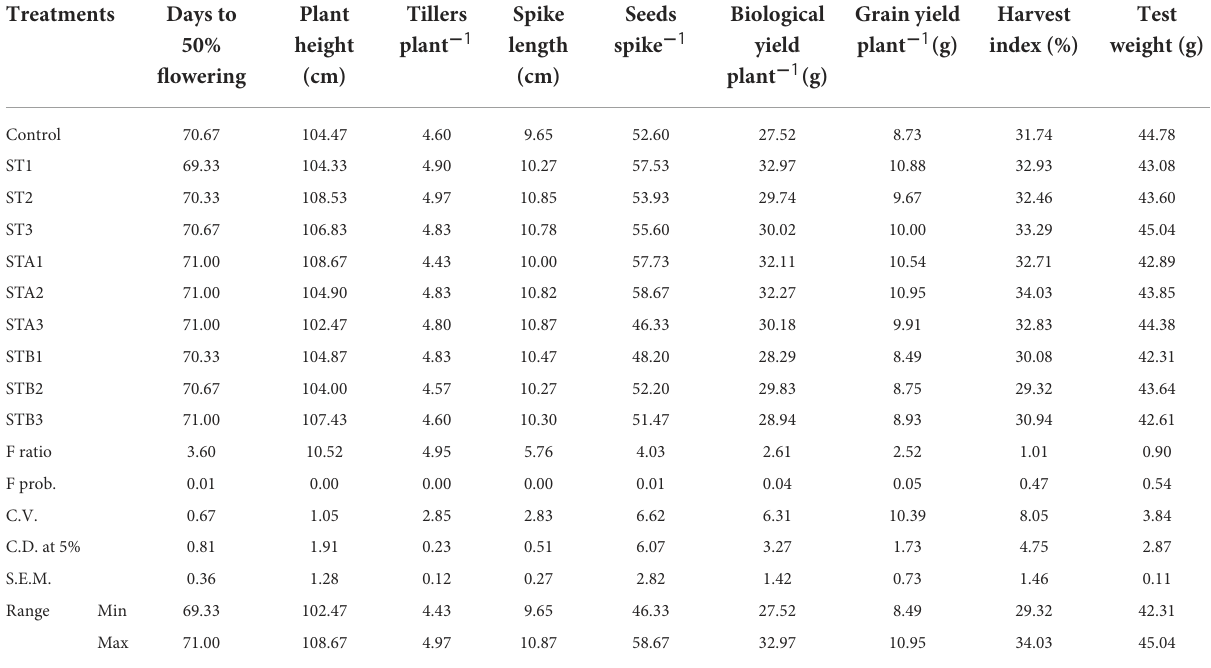
TABLE 3 Effect of calliterpenone on yield and yield contributing traits in wheat.